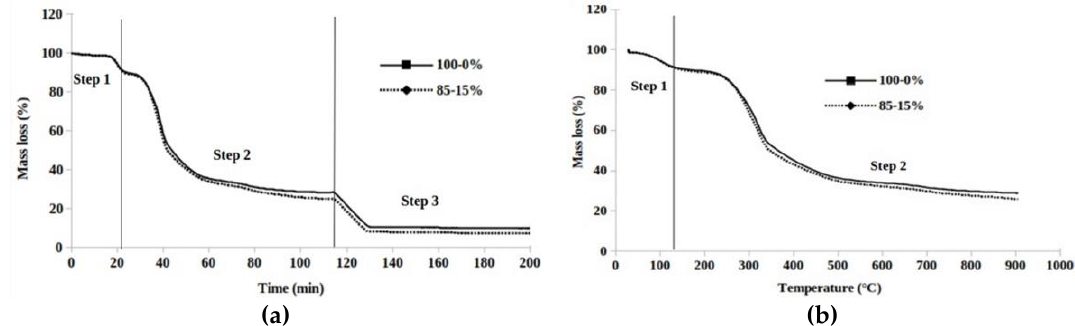
Figure 4. ( a ) TG curve of the 85%-15% and 100%-0% briquettes as a function of the time during pyrolyis step followed by the char oxidation (Step 3); ( b ) TG curve of the 85%-15% and 100%-0% briquettes as a function of the temperature during only pyrolysis step.